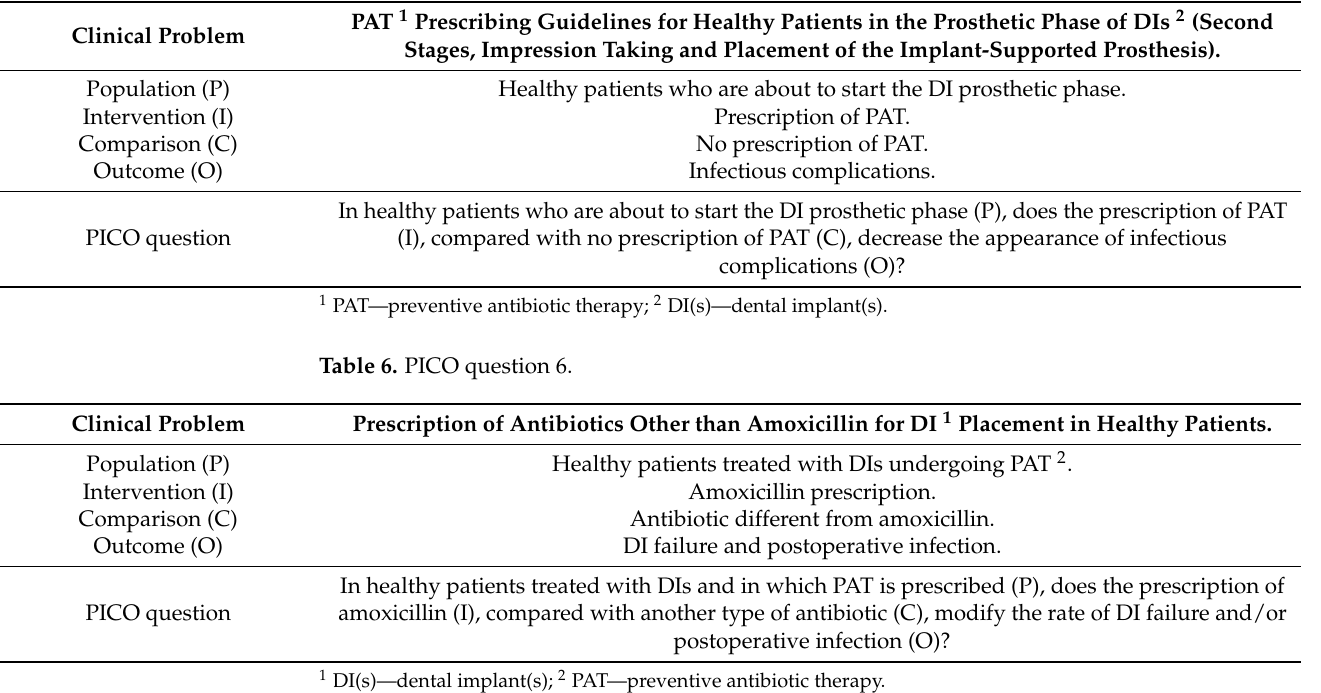
Table 5. PICO question 5.